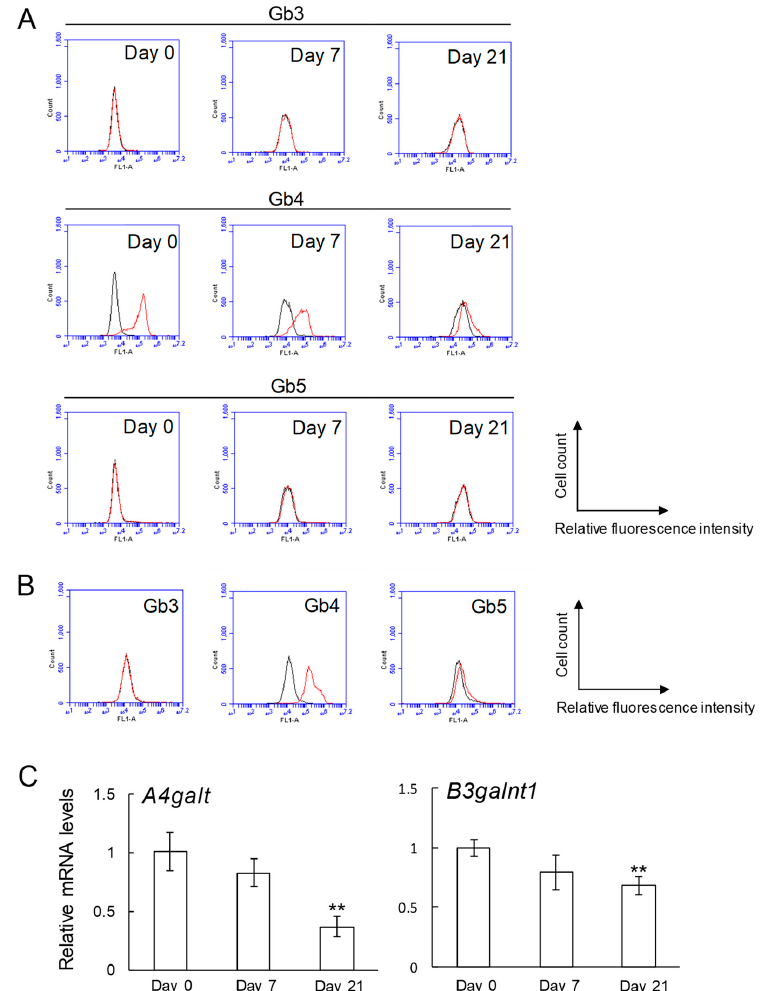
Figure 2. Expression of glycosphingolipids (Gb3, Gb4, and Gb5), and Gb3 and Gb4 synthase genes in osteoblasts. ( A ) Expression of globo-series glycosphingolipids (Gb3, Gb4, and Gb5) in MC3T3 E1 cells on days 0, 7, and 21 after induction of osteoblastogenesis by flow cytometric analysis. ( B ) Expression of globo-series glycosphingolipids (Gb3, Gb4, and Gb5) in SaM-1 cells by flow cytometric analysis. Red line: anti-globo-series glycosphingolipids (Gb3, Gb4, and Gb5) monoclonal antibodies (mAbs) ( + ), gray line: anti-globo-series glycosphingolipids mAbs (-). ( C ) mRNA expression of A4galt and B3galnt1 in MC3T3 E1 cells on days 0, 7, and 21 after induction of osteoblastogenesis ( n = 3). Data are expressed as mean ± S.D. The double asterisks indicate p <